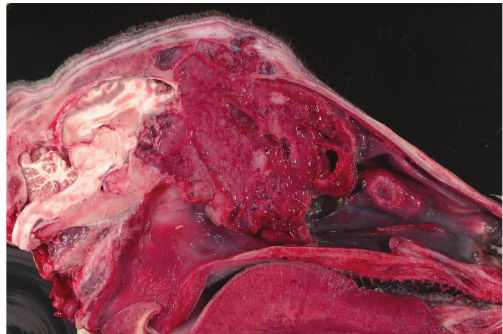
Figure 5: Gross image of the tumor invading the nasal cavity and compressing the cerebrum at necropsy (courtesy of Dr. Allison C.